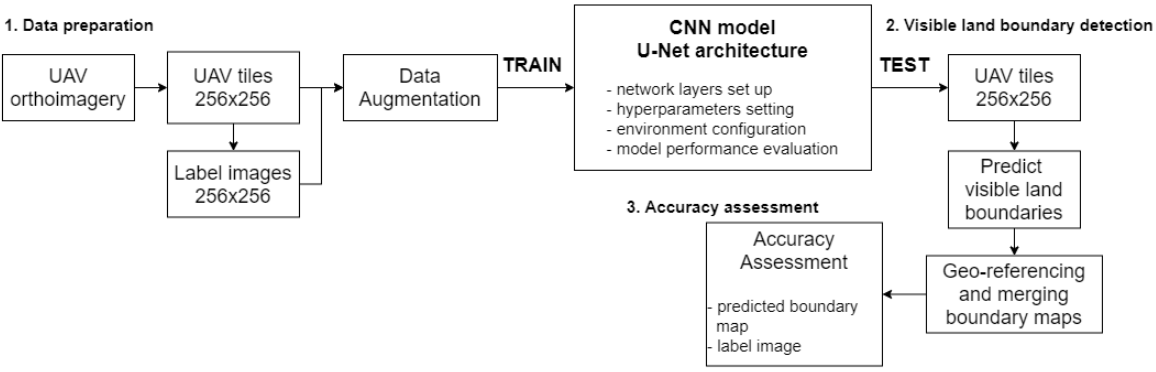
Figure 3. Workflow for the detection of visible land boundaries based on the U-Net model.